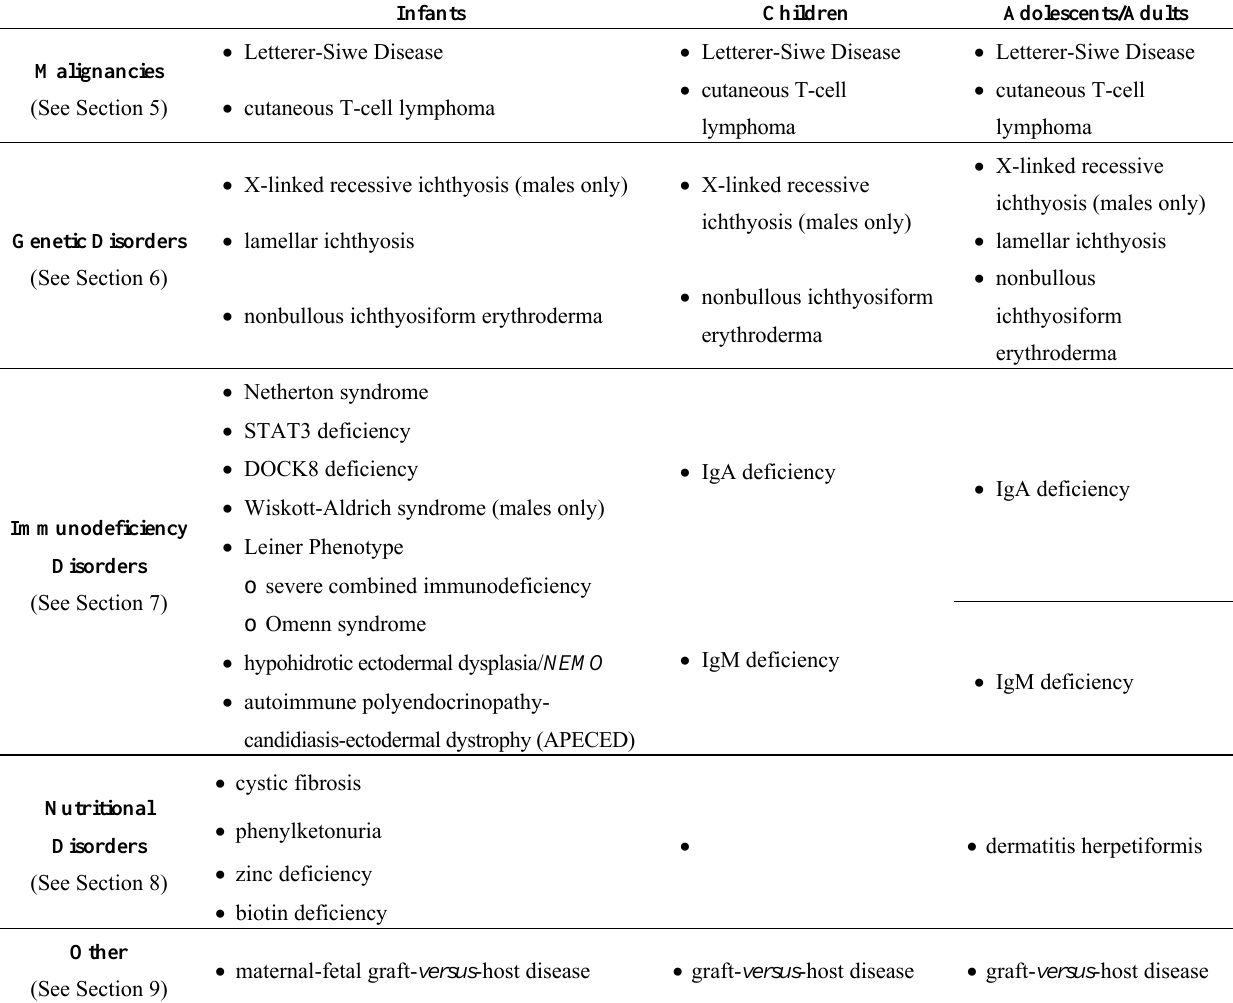
Table 3. Differential diagnosis of atopic dermatitis: Rare disorders by age group. Ig indicates